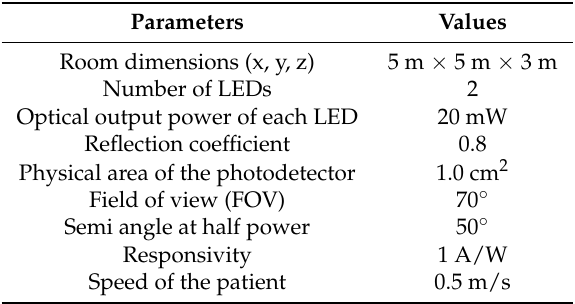
Figure 10. Experiments: ( a ) Mobility scenario 1. ( b ) Mobility scenario 2. Table 3. Experiment